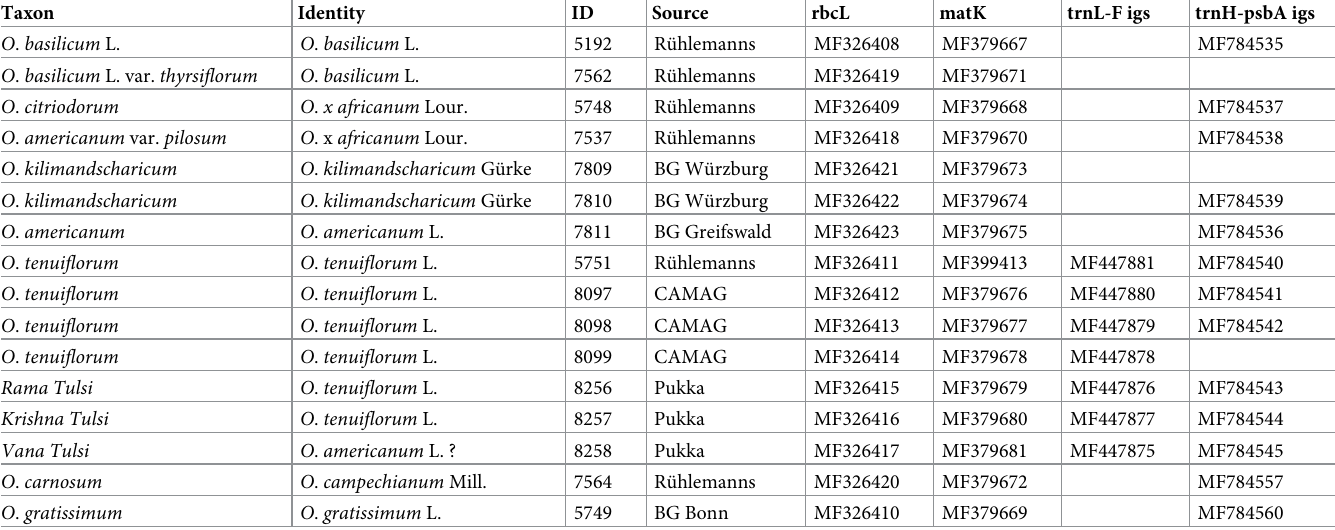
Table 1. Ocimum accessions used in this study; Internal accession ID and source, identity after morphological authentication, and Genbank accession numbers of the sequences isolated from these accessions. Note: under accession the designation of the provider is listed, in case that not an accepted name has been used, the official name, based on The Plant List (http://www.theplantlist.org/) has been added in brackets.